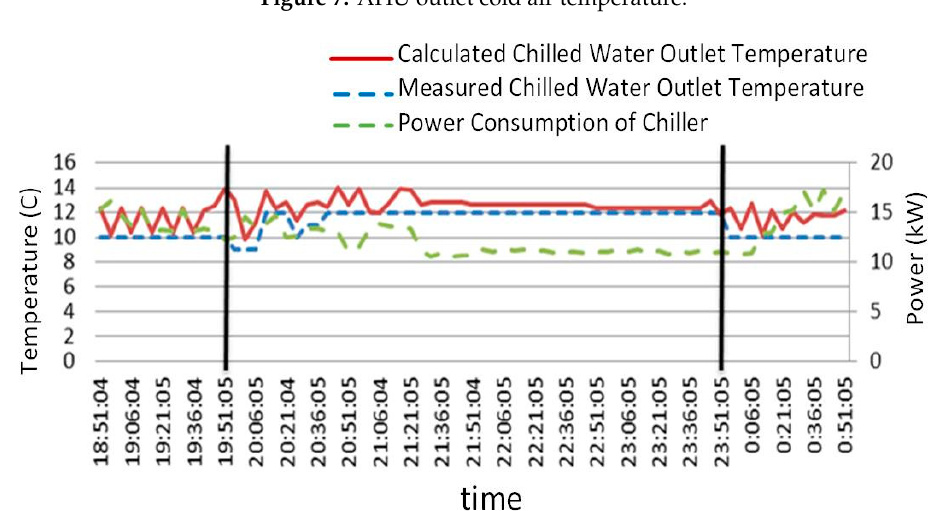
Figure 8. Calculated and measured chilled water outlet temperature and chiller power